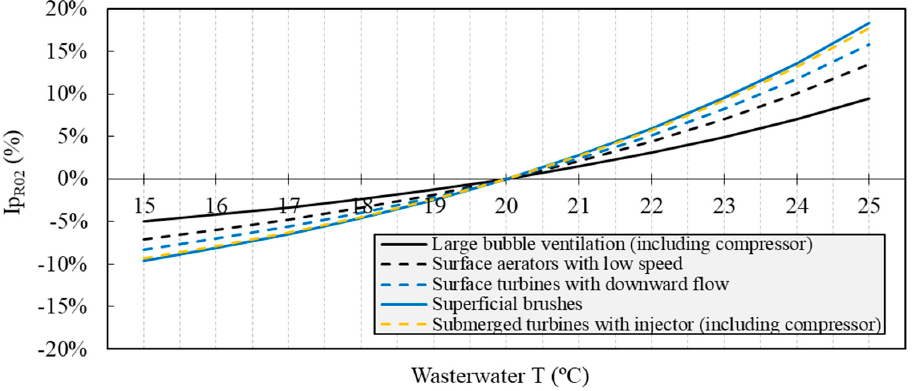
Figure 2. Ip RO2 values as a function of wastewater T for five aeration systems.